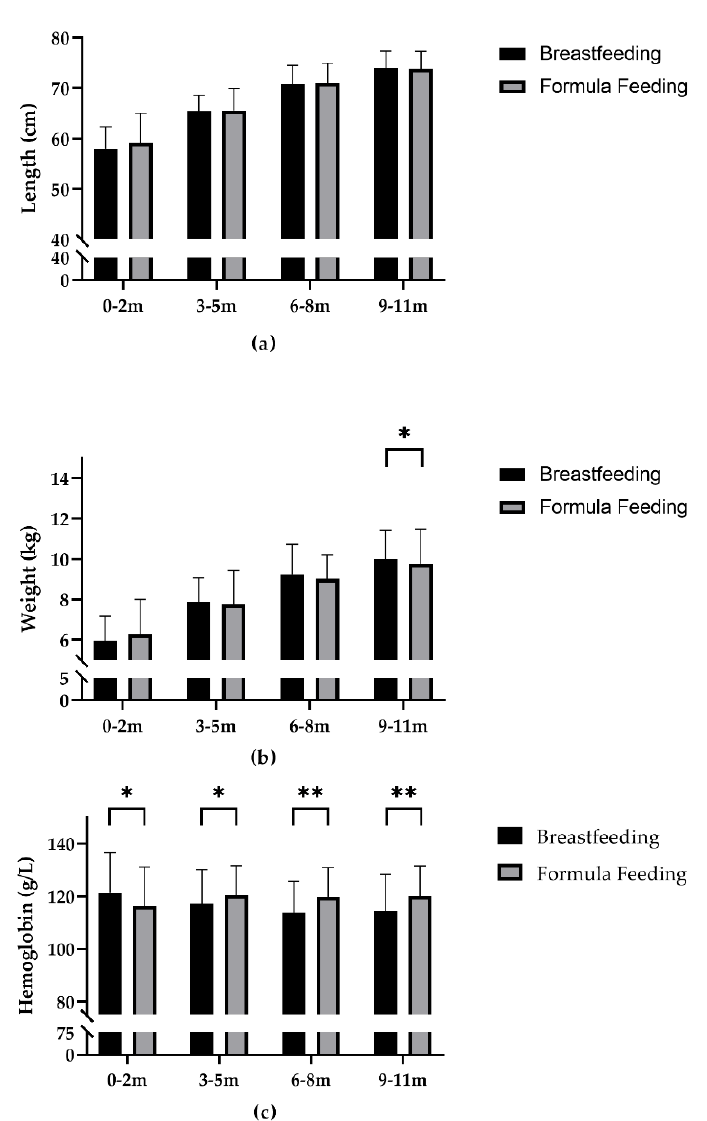
Figure 2. ( a ) Body length in breastfeeding and formula feeding 0–2, 3–5, 6–8 and 9–11 month infants was 58.0 ± 4.4 vs. 59.1 ± 5.9, 65.4 ± 3.2 vs. 65.5 ± 4.5, 70.8 ± 3.7 vs. 71.0 ± 4.0, and 73.8 ± 3.5 vs. 73.8 ± 3.5, respectively; ( b ) body weight in breastfeeding and formula feeding 0–2, 3–5, 6–8 and 9–11 month infants was 6.0 ± 1.2 vs. 6.3 ± 1.8, 7.9 ± 1.2 vs. 7.8 ± 1.7, 9.3 ± 1.5 vs. 9.0 ± 1.2, and 10.0 ± 1.4 vs. 9.8 ± 1.7, respectively; ( c ) hemoglobin in breastfeeding and formula feeding 0–2, 3–5, 6–8 and 9–11month infants was 121.4 ± 15.2 vs. 116.3 ± 14.8, 117.1 ± 13.0 vs. 120.4 ± 11.3, 113.9 ± 11.9 vs. 119.8 ± 11.2, and 114.4 ± 14.0 vs. 120.0 ± 11.5, respectively; * p < 0.05; ** p < 0.01. Table 2. Infant physical development in breastfeeding and formula feeding group after matching. Breast Feeding Formula Feeding